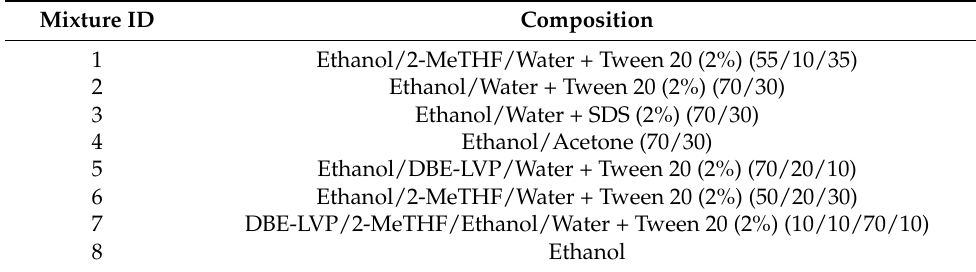
Figure 1. Vandalism carried out on selected specimens for cleaning tests. Table 3. Solutions used in the research.